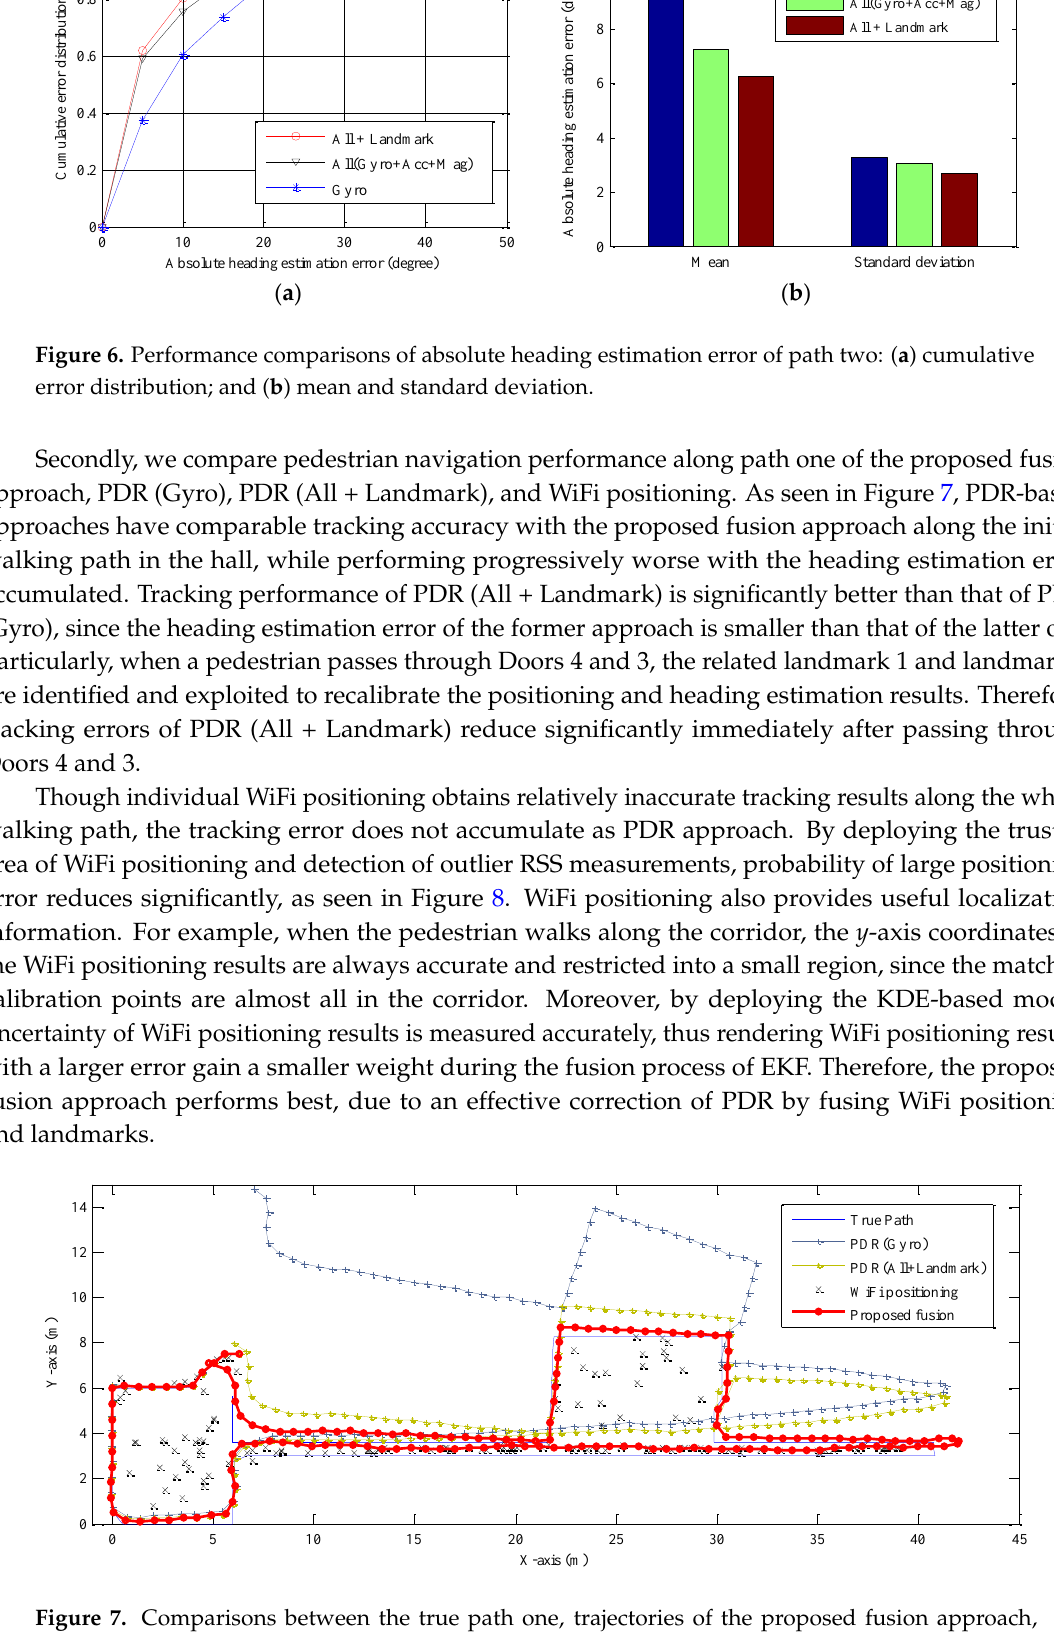
Figure 5. Performance comparisons of absolute heading estimation error of path one: ( a ) cumulative error distribution; and ( b ) mean and standard deviation.